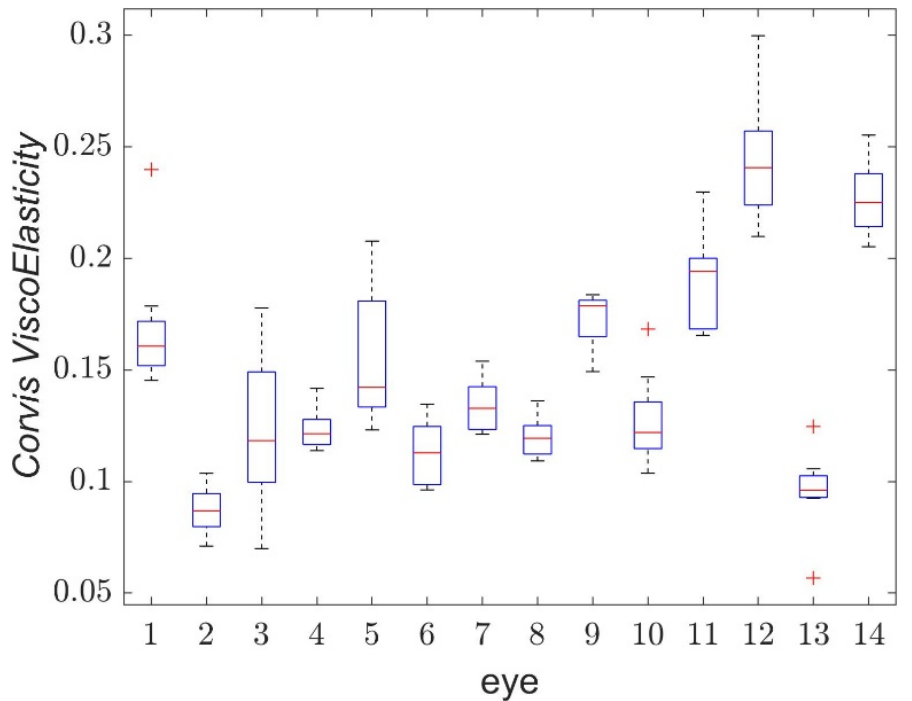
Figure 6. Correlations of parameters dT 1